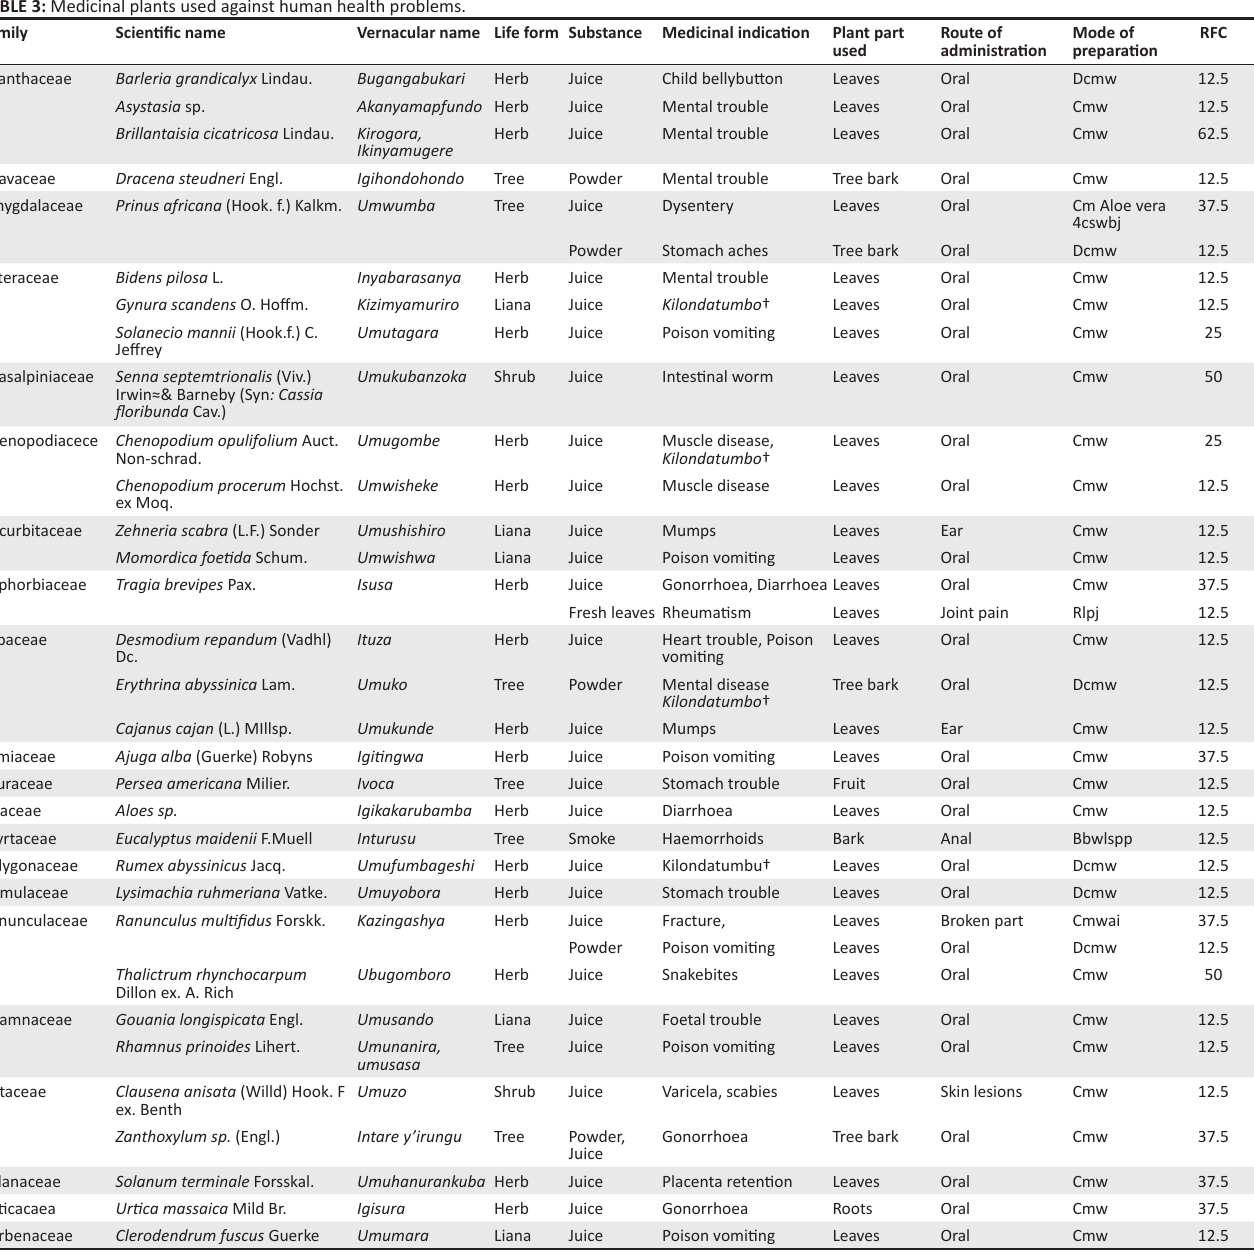
TABLE 3: Medicinal plants used against human health